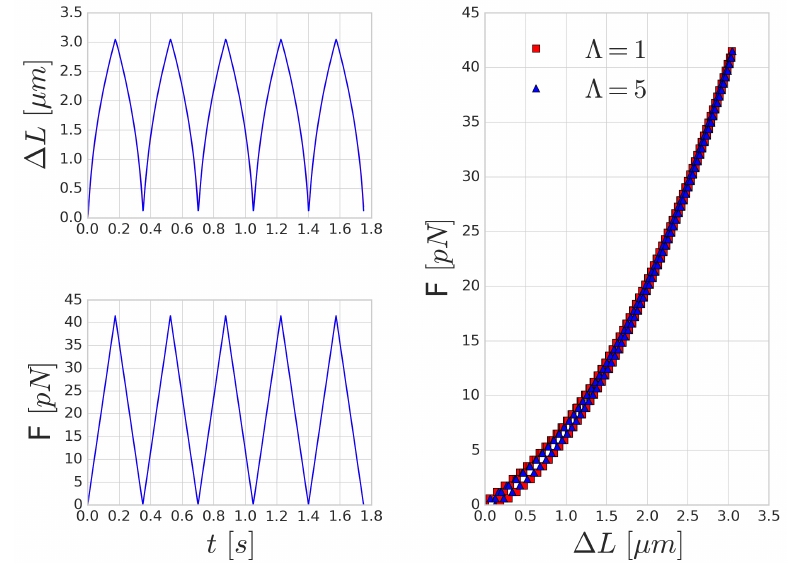
Figure 5. Stretching results with a period of 0.35 s: ( Top left ) The elongation of the longest axis of the RBC ( ∆ L ) over time. ( Bottom left ) The magnitude of the force applied on opposing membrane areas over time. ( Right ) The applied force magnitude versus the corresponding elongation of the cell.